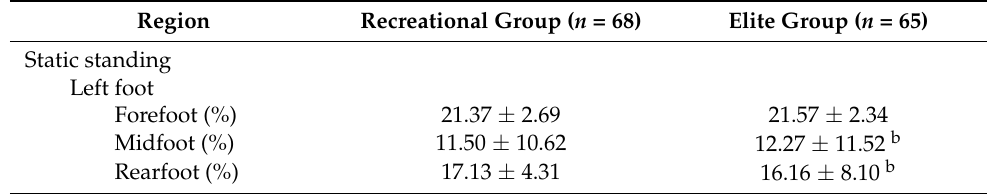
Table 3. Bipedal plantar pressure distributions of the three regions under static and dynamic